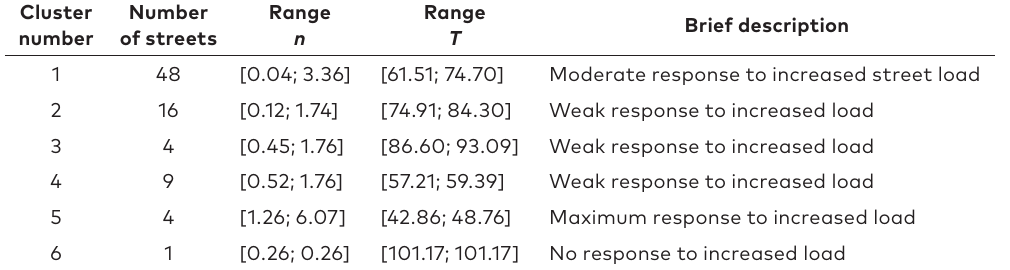
Table 1. The characteristics of the obtained clusters